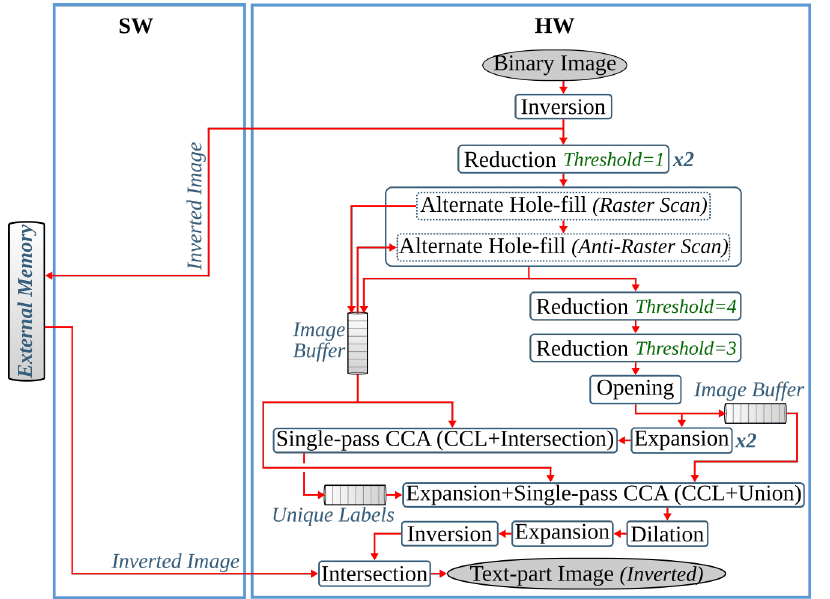
Figure 12. Hardware-software partitioning of text and image segmentation for the i DocChip